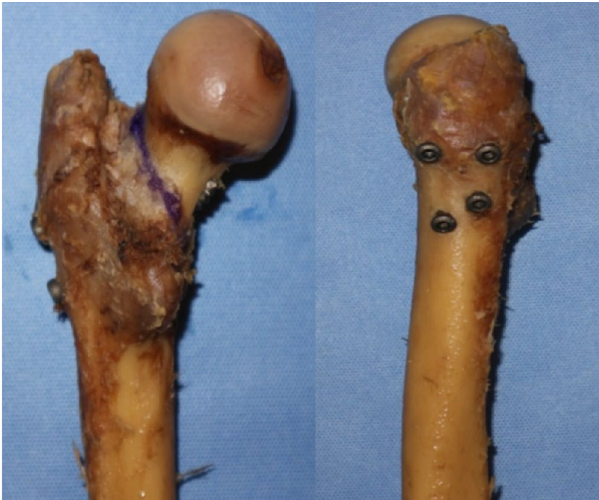
Figure 2. Specimens of medial femoral neck support screw.